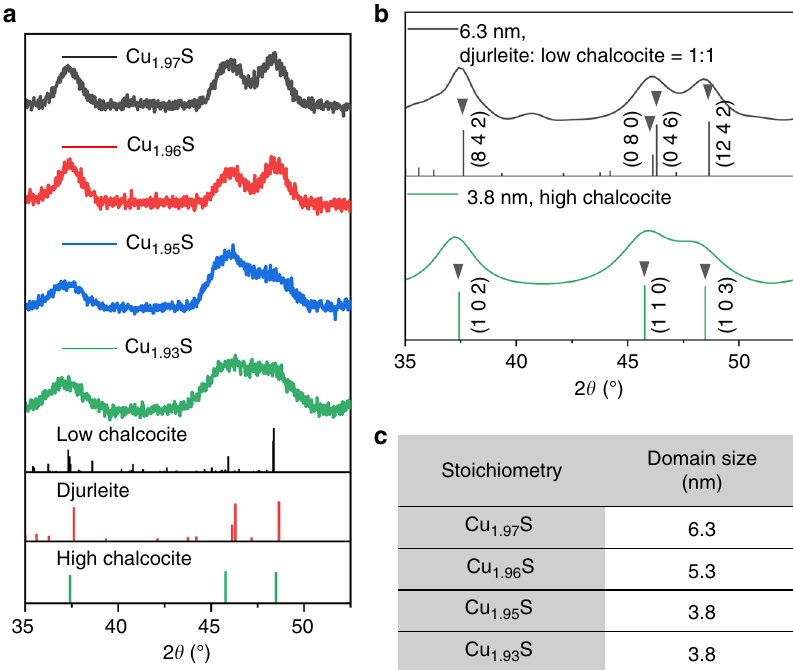
Fig. 4 Sub-stoichiometry-dependent crystallographic structures of the NCs. a Experimental PXRD patterns of Cu 2 − x S NCs for four levels of sub- stoichiometry. Reference patterns are also shown for low chalcocite (JCPDS # 33 – 0490), djurleite (JCPDS # 23 – 0959) and high chalcocite (JCPDS # 26 – 1116) by stick patterns. b Simulated PXRD patterns of Cu 2 − x S NCs in a 1:1 mixture of djurleite: low chalcocite phase and a high chalcocite phase with key peaks assigned to speci fi c Miller planes. For the input parameters for each simulated pattern, refer to Supplementary Tables 1 – 3. Reference patterns are also shown for djurleite (black sticks) and high chalcocite (green sticks). c NC domain size determined from Debye-Scherrer broadening (see Supplementary Table 4) of the 2 θ ~37° re fl ection of the experimental PXRD pattern